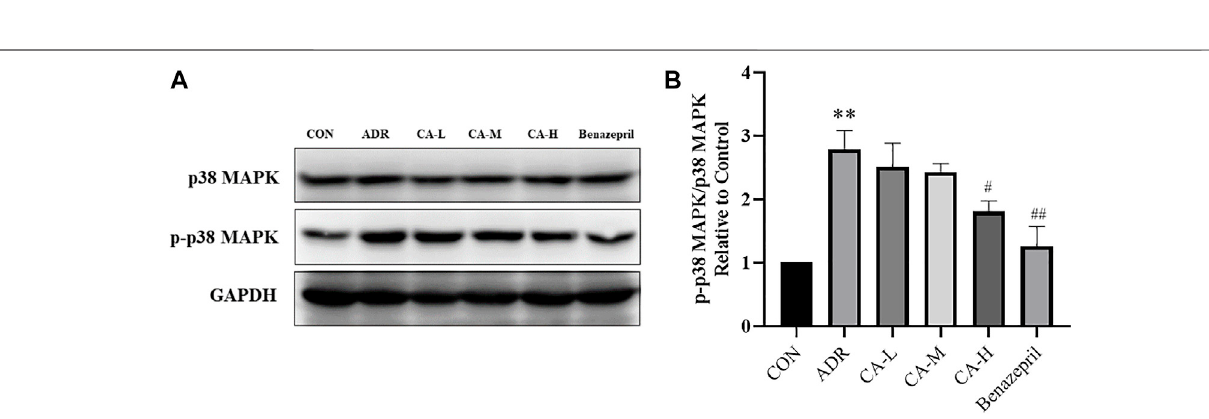
Frontiers in Pharmacology |